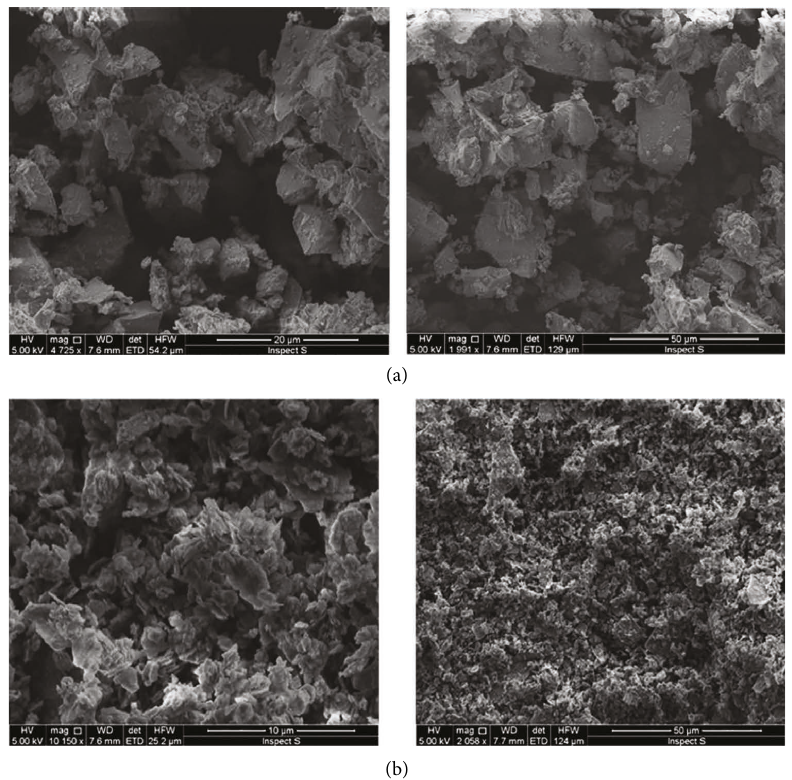
Figure 2: SEM observations for powders (a) GGBFS and (b)